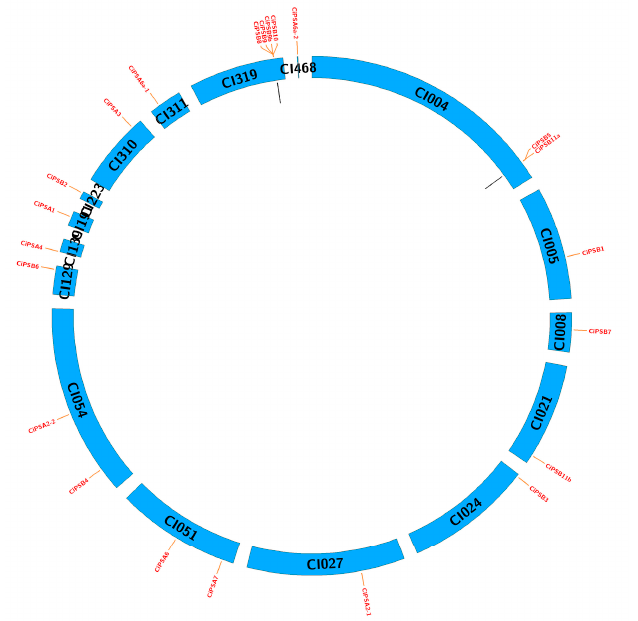
Figure 3. Chromosomal distribution and expansion analysis of the CiPS gene family members in grass carp. grass